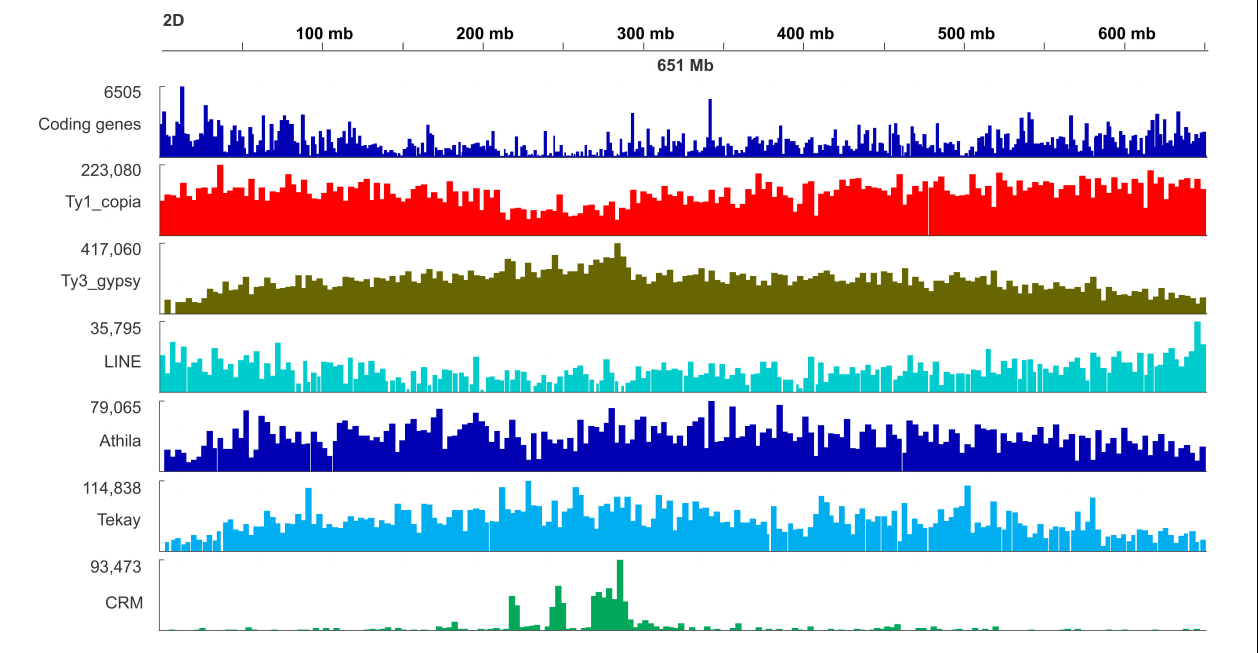
FIGURE 6 | Distribution map of genes and selected retrotransposon lineages including Ty1/copia, Ty3/gypsy, LINE, Athila, Tekay, and CRM retrotransposons along the chromosome 2D of Ae. tauschii